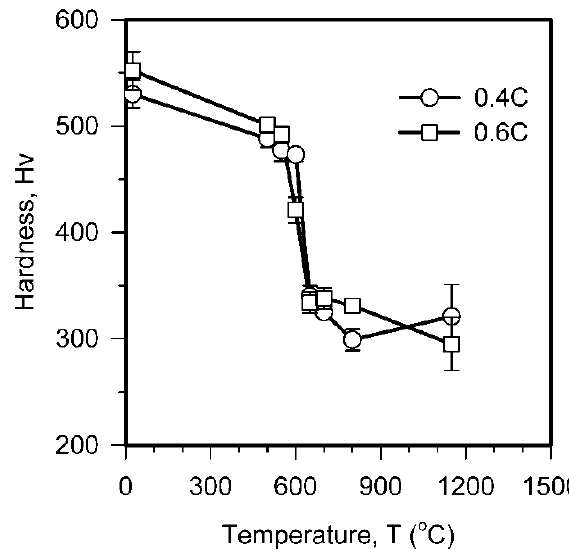
Figure 2. Effect of annealing temperature on hardness of Fe-0.4C-18Mn and Fe-0.6C-18Mn steels (0.4C and 0.6C, respectively) subjected to cold rolling.